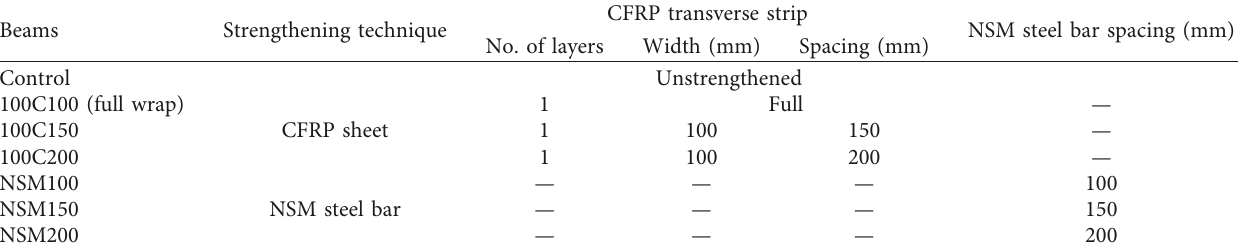
Table 1: Design of the concrete beams.